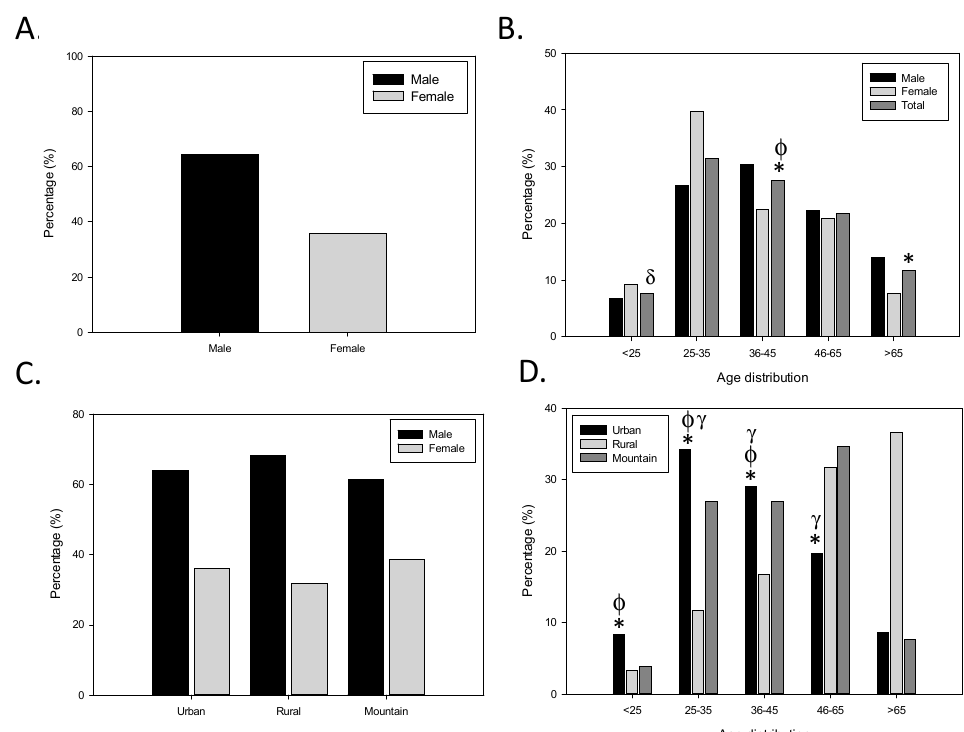
Figure 1. Patient and pharmacy distribution profile. Distribution of participants according to ( A ) sex, ( B ) age and sex, ( C ) type of pharmacy and sex and ( D ) type of pharmacy and age of the participants. The proportions are calculated from each condition related to 548 notifications analysed. Patient distribution profile was not equally distributed among sexes, age or type of pharmacies. These differences were even more clear when the age and type of pharmacy analysis was performed together. Statistical differences: ( B ) * p < 0.05 vs. range 25–35, (cid:31) p < 0.05 vs. range < 25, δ p < 0.05 vs. range > 65 and ( D ) * p < 0.05 U/R in range > 65, (cid:31) p < 0.05 U/R vs. range 46–65, γ p < 0.05 R/M in range > 65.